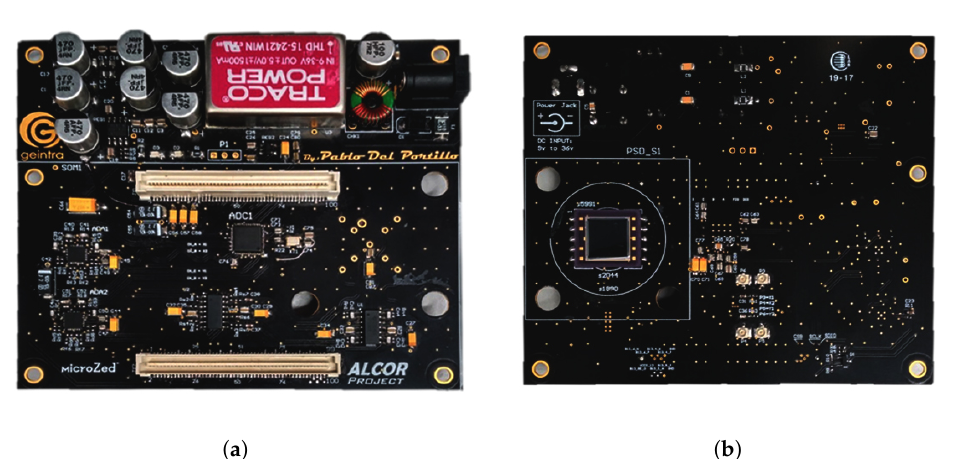
Figure 20. The receiver used in the experimental tests, ( a ) back and ( b ) front.